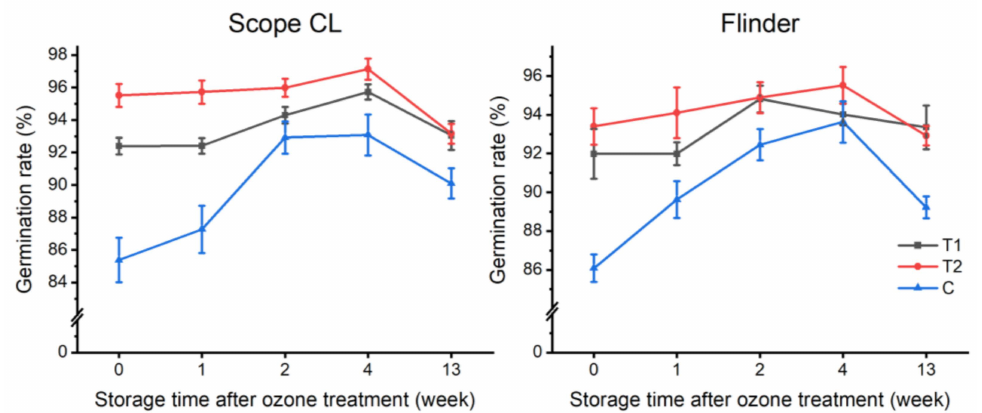
Figure 2. The effect of ozone treatments at different time on seed dormancy alleviation based on three independent factors, i.e., variety (Scope CL and Flinder), ozone treatment duration (T1 = 15 min, T2 = 120 min of 700 ppm ozone treatment, C = control), and storage time after ozone treatment (immediately, 1, 2, 4, and 13 weeks of storage). The data represent the average of eight replications, and the bars represent standard